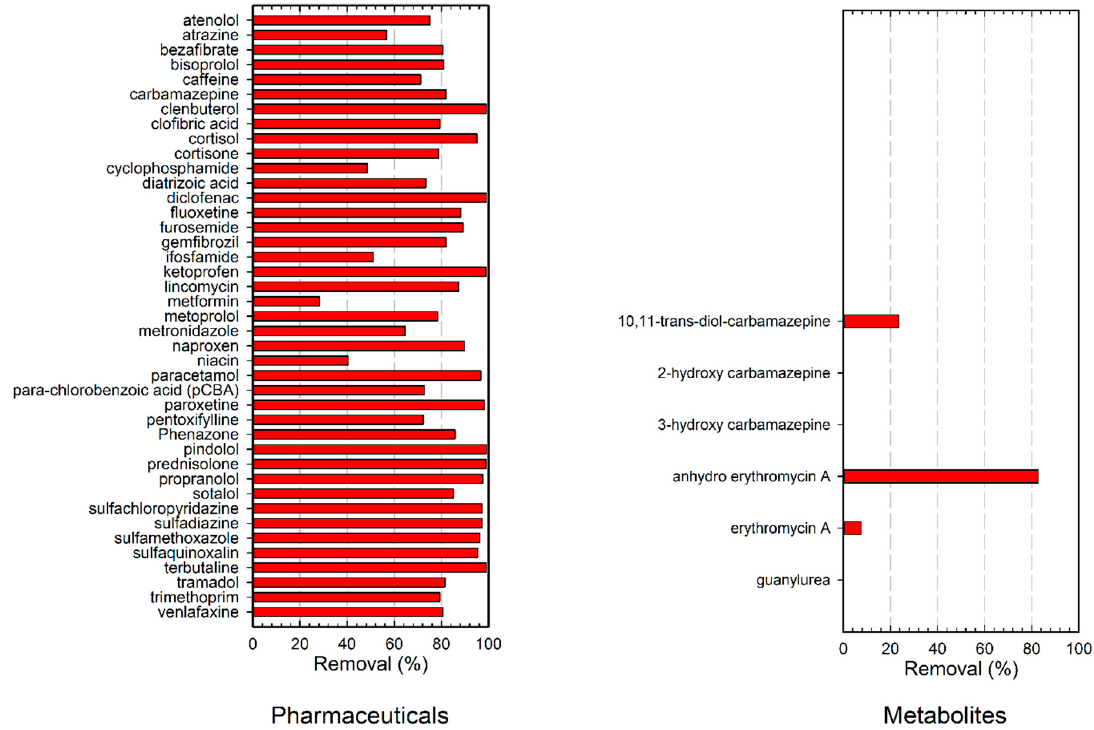
Figure 6. Removal of pharmaceuticals (left graph) and metabolites (right graph) at drinking water production site Heel, applying a UV dose of 365 mJ/cm 2 and a H 2 O 2 concentration of 10 mg/L.